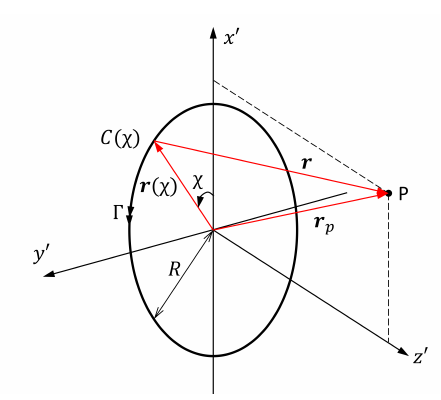
Figure 1. Coordinate system associated with a vortex